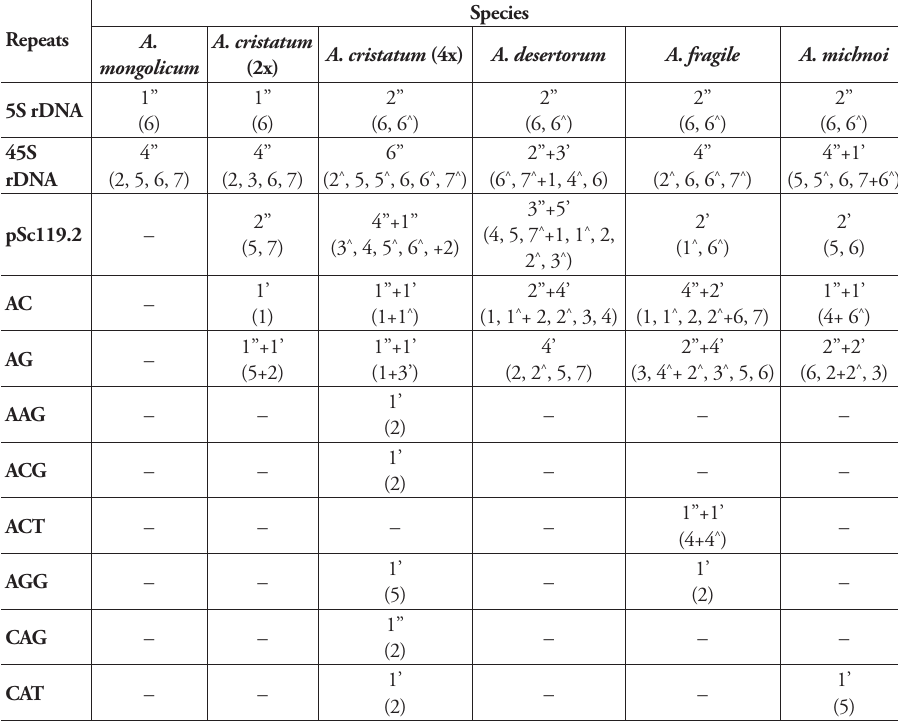
Table 2. Number of hybridization sites and chromosomal distribution of the repetitive sequences for each Agropyron